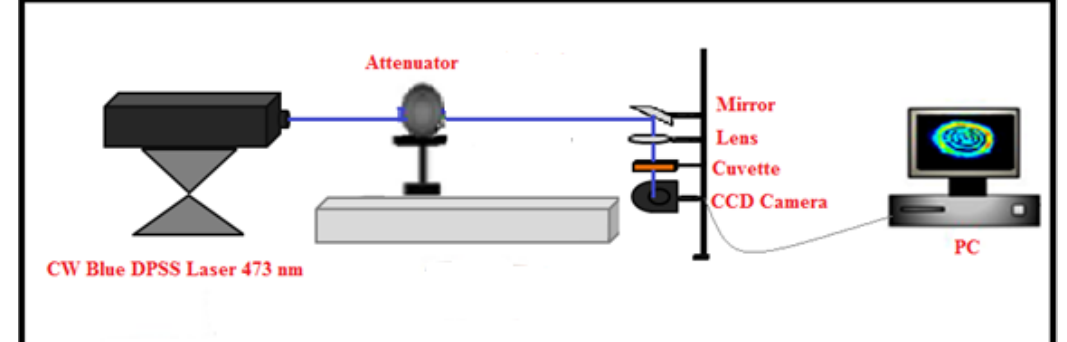
Fig.1: Schematic diagram of the experimental set